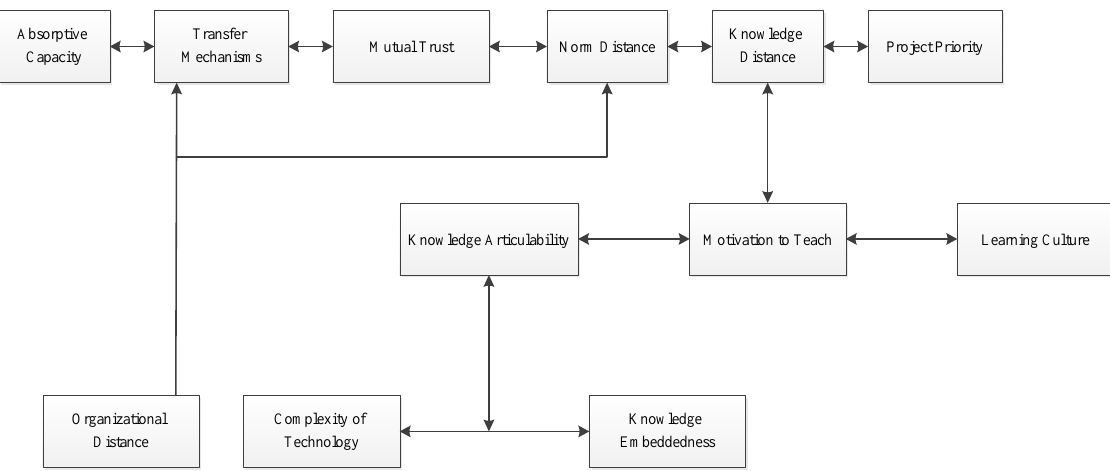
Fig. 4. ISM-based model for technology transfer from Iranian RTOs to local firms Step 5: MICMAC